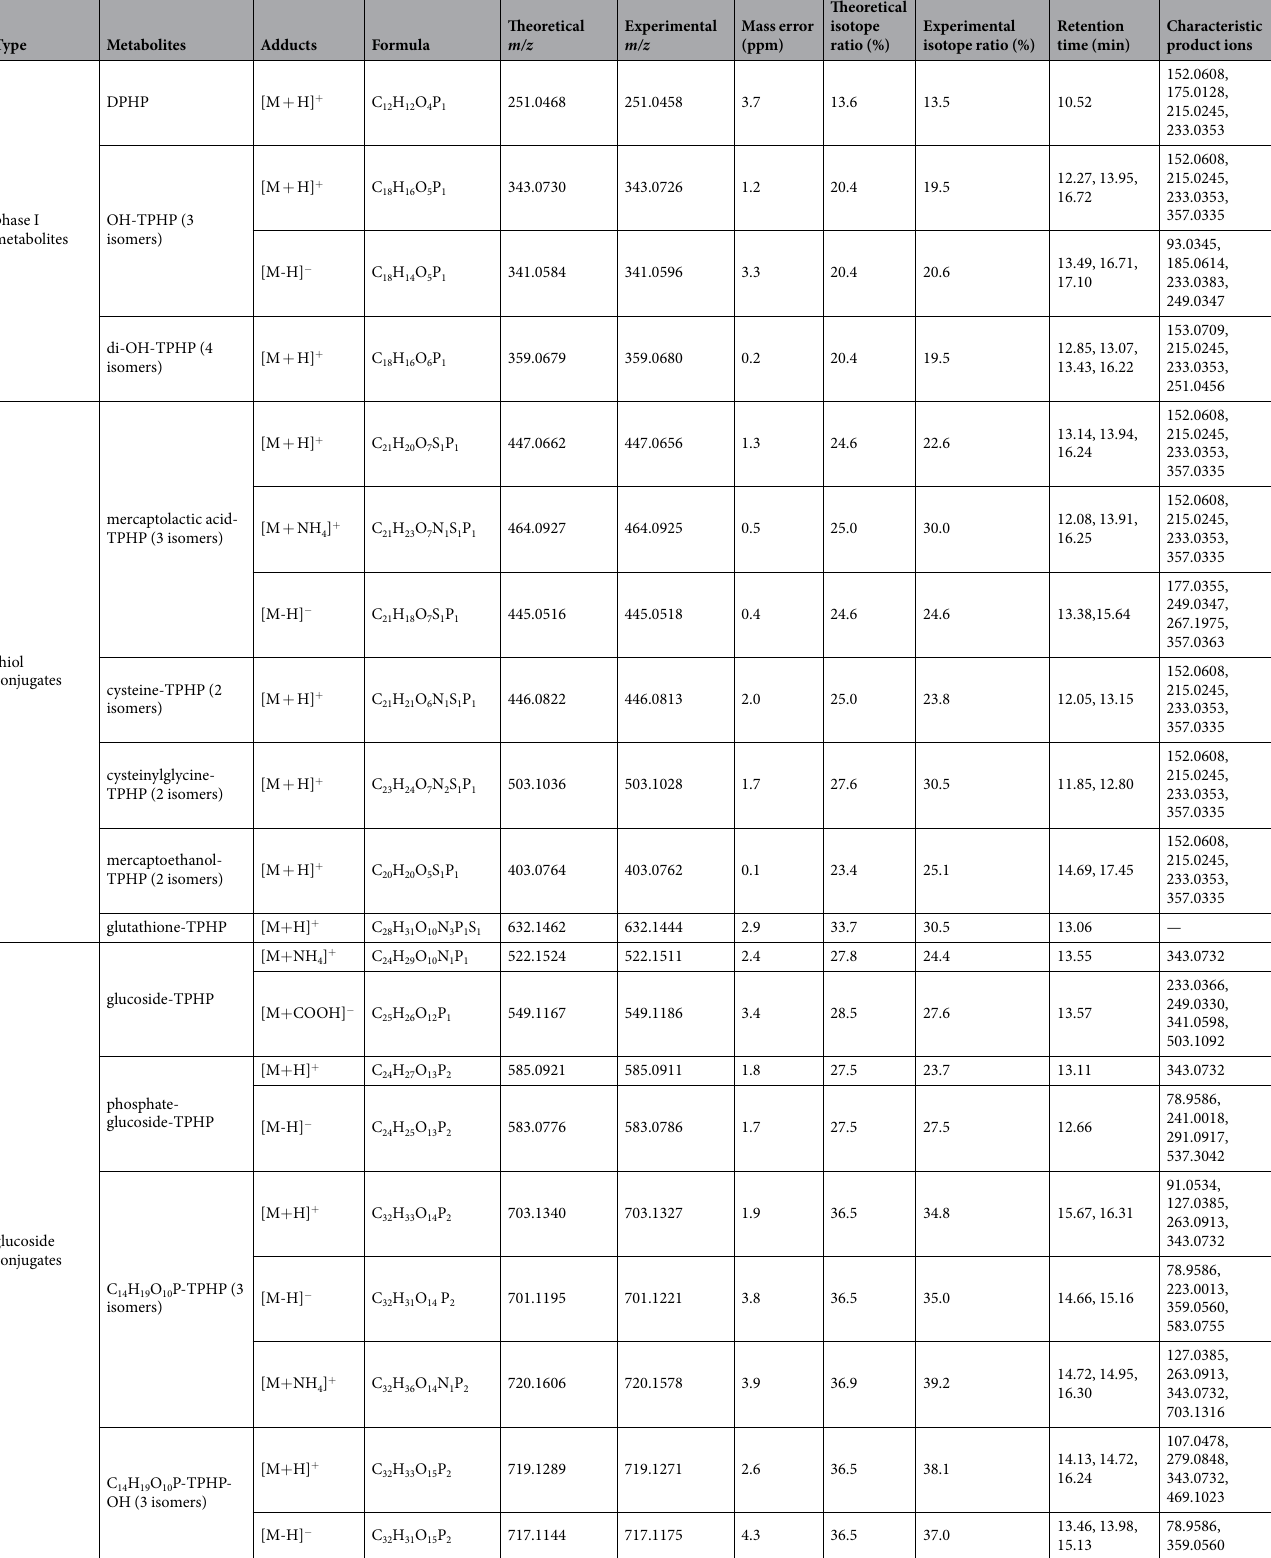
Table 1. Identified TPHP metabolites in earthworms from LC-QTOF spectra after 28 days of TPHP exposure in soil. The structure of C 14 H 19 O 10 P could not be unambiguously identified by MS/MS spectra, and are tentatively proposed in Supplementary Fig.